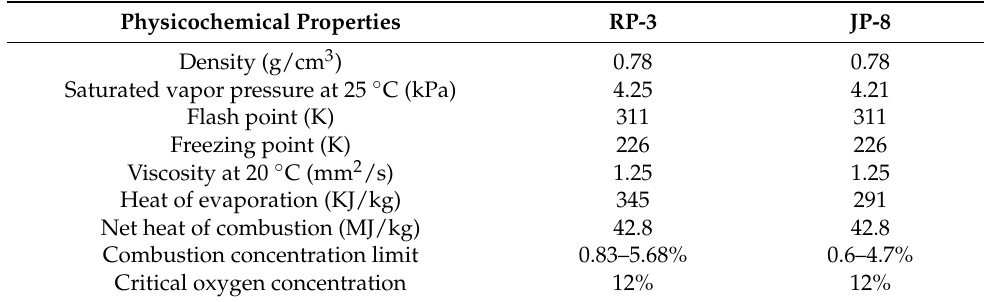
Figure 1. Model and real equivalent fuel tank of F-22 fighter aircraft. Table 1. Physicochemical properties of RP-3 and JP-8 [4,16,22].